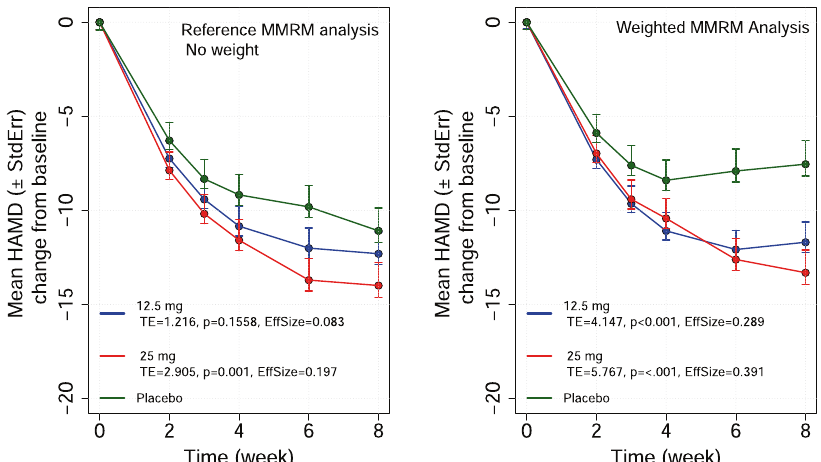
Fig. 3 MMRM longitudinal analysis. Results of the non-weighted and weighted MMRM analyses with the estimation of the effect sizes. The LS mean (± standard error) of the longitudinal HAMD-17 total score changes from baseline are presented by